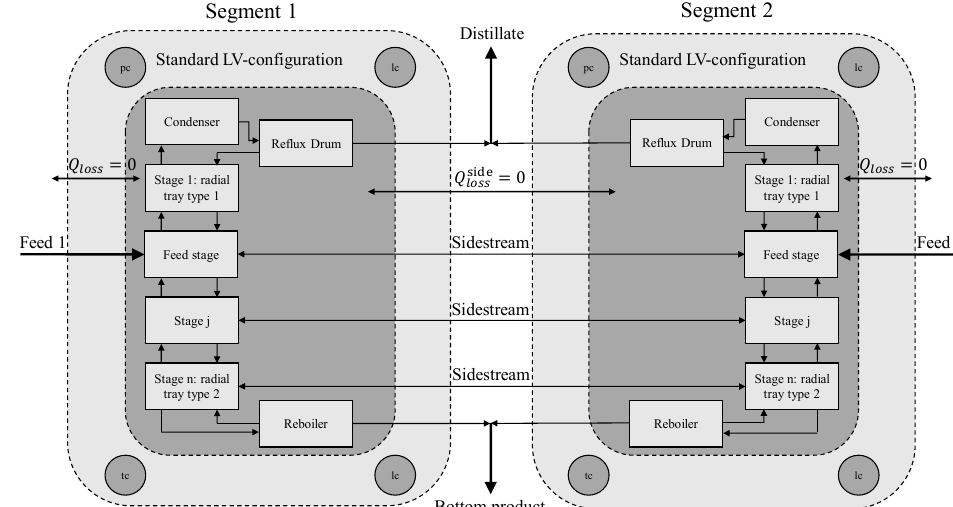
Figure 3. Structure of the segmented column model.